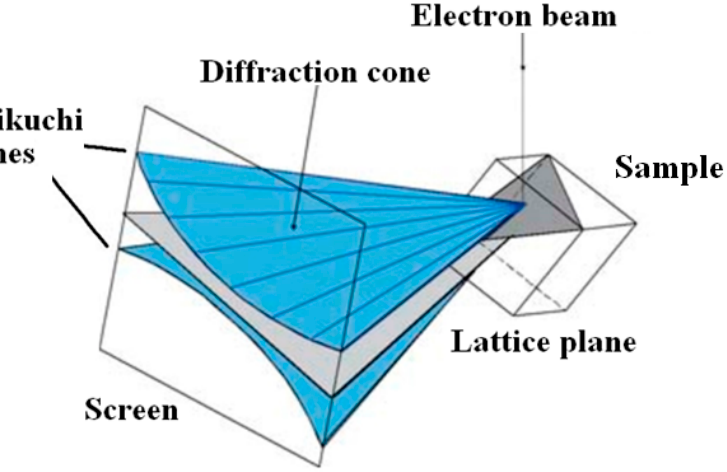
Figure 6. Obtaining of Kikuchi Lines in a scanning electron microscope by the EBSD method.